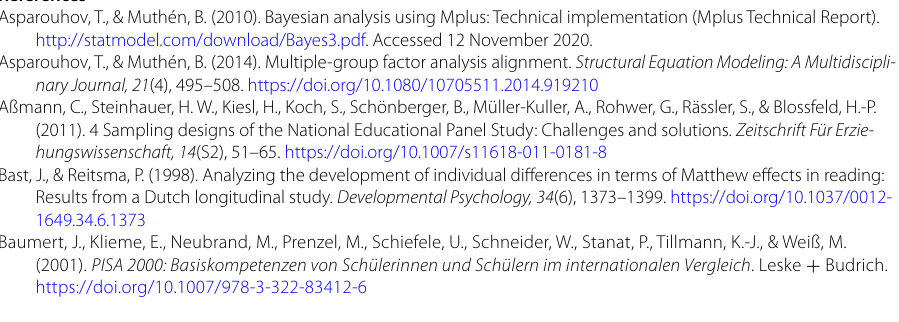
Table S3 . Results of models for longitudinal competence development using WLEs (N standard error estimation. Table S4 . Results of models for longitudinal competence development using WLEs (N